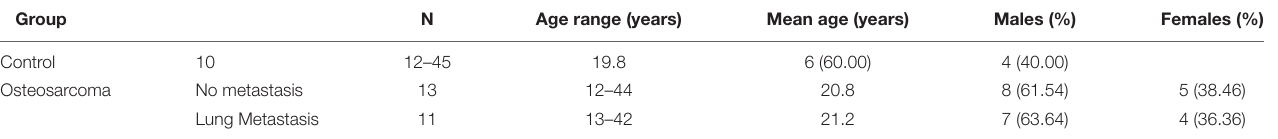
TABLE 1 | Patient Demographics.